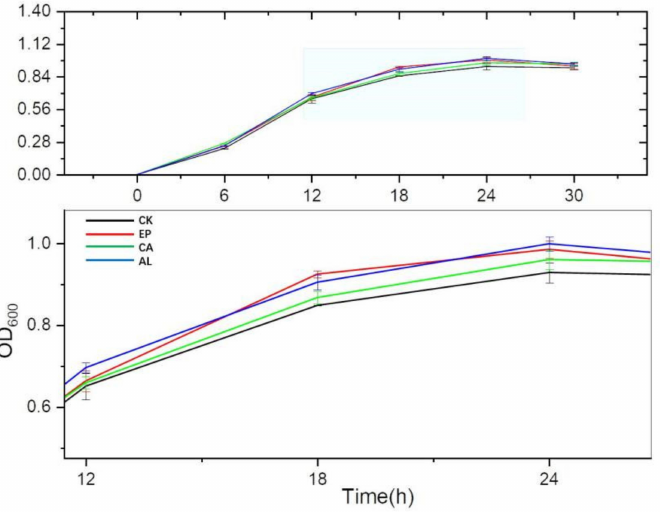
Figure 3. Effects of Enteromorpha linza polysaccharides (EP), carrageenan (CA), sodium alginate (AL) on the growth of Bacillus subtilis